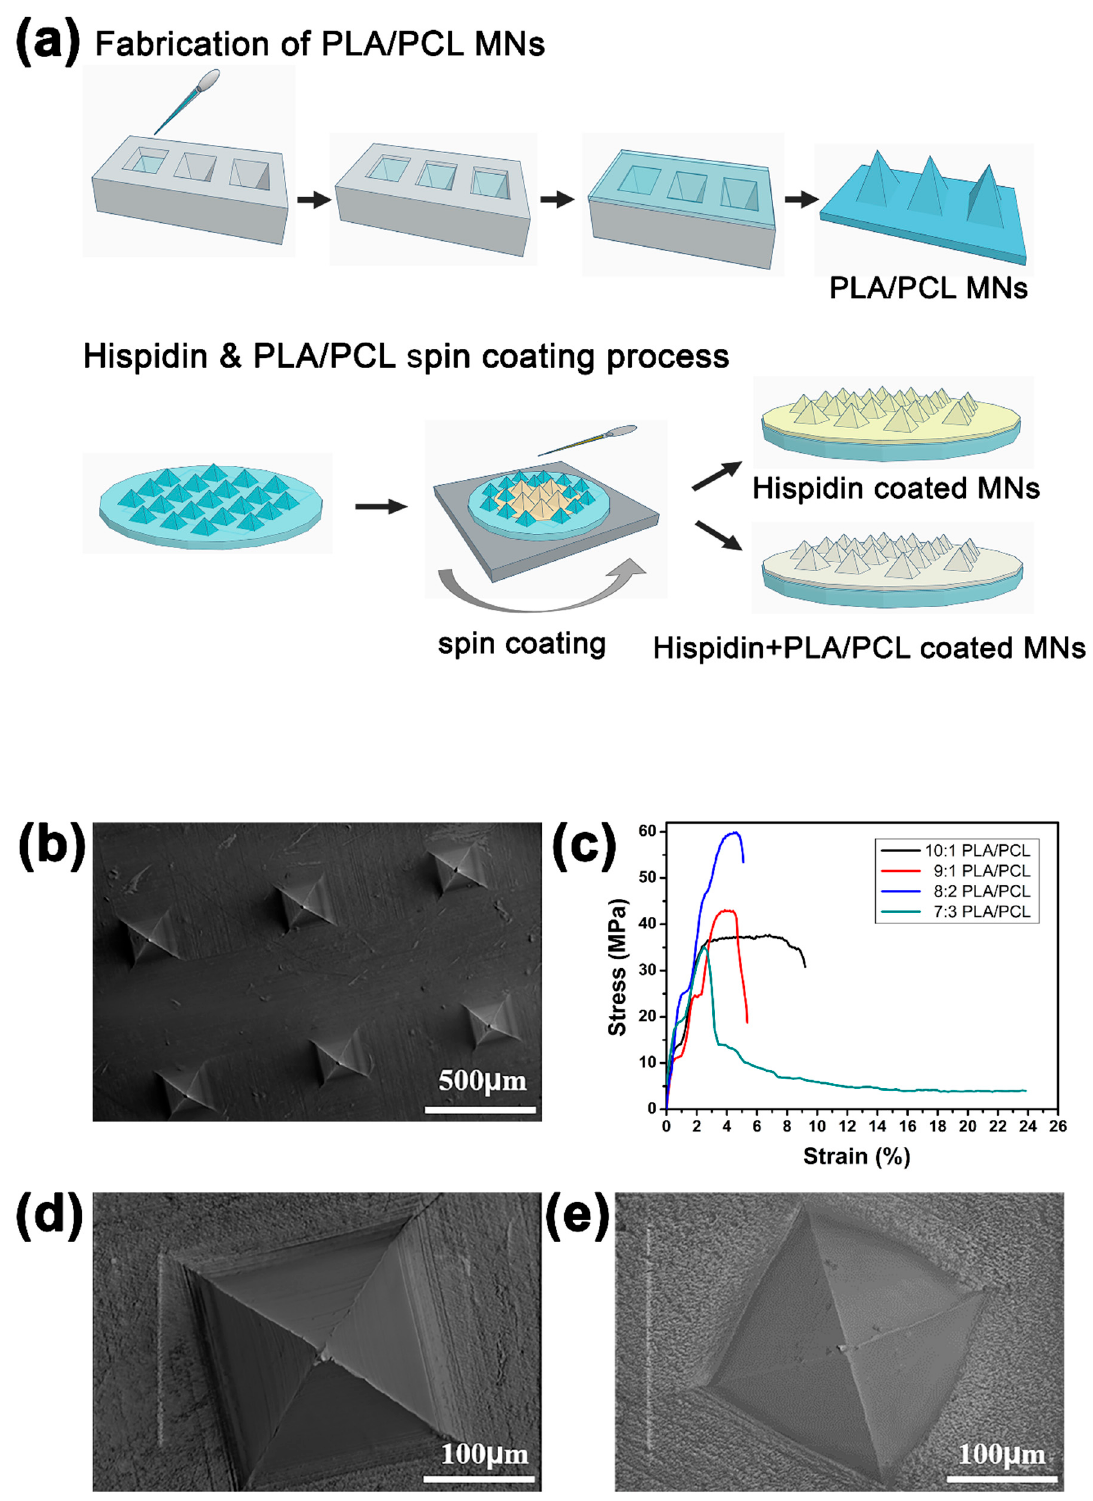
Figure 1. Microstructure and mechanical strength of microneedles (MNs). ( a ) Fabrication process of MNs. ( b ) SEM image of casted pristine polylactic acid (PLA)/polycaprolactone (PCL) MNs. ( c ) Stress–strain graph of various PLA/PCL blended structures. ( d ) SEM image of MNs after coating of hispidin delivery layer. ( e ) SEM image of MNs after coating of hispidin with PLA/PCL blended polymer delivery layer.